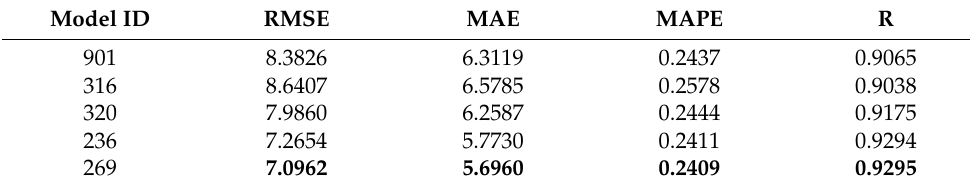
Table 4. Comparison of performance measures for MGGP